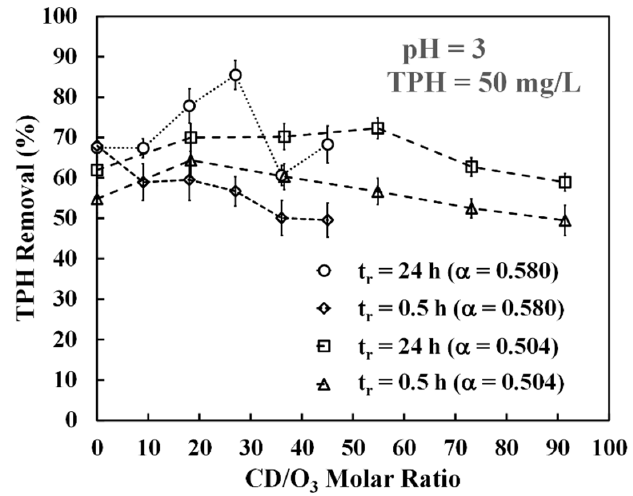
Figure 10. TPH removal by the O 3 - β CD inclusion complex. The removal efficiency is plotted as a function of the CD/O 3 molar ratio under various treatment conditions. function of the CD/O 3 molar ratio under various treatment